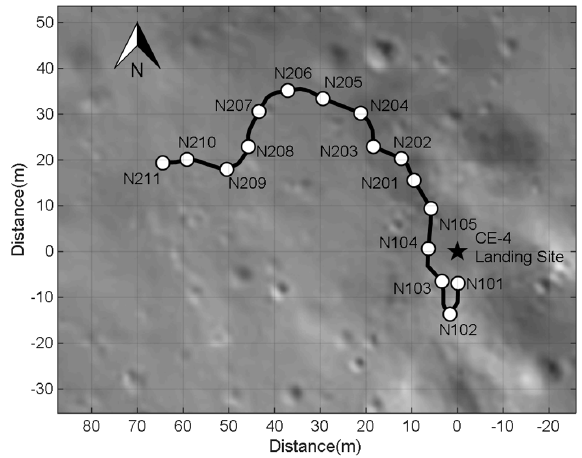
Figure 3. The walking route of Yutu-2 rover for the first day and the second day on the Moon. Figure 3. The walking route of Yutu ‐ 2 rover for the first day and the second day on the Moon. Figure 3. The walking route of Yutu ‐ 2 rover for the first day and the second day on the Moon. Figure 3. The walking route of Yutu ‐ 2 rover for the first day and the second day on the Moon.